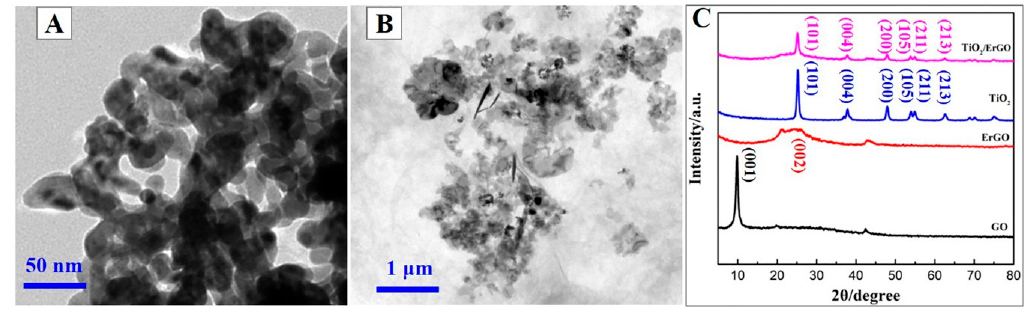
Figure 1. TEM images of TiO 2 nanoparticles (NPs) ( A ) and TiO 2 /GO nanocomposites ( B ); ( C ) XRD patterns of GO, ErGO, TiO 2 and TiO 2 /ErGO nanocomposites.